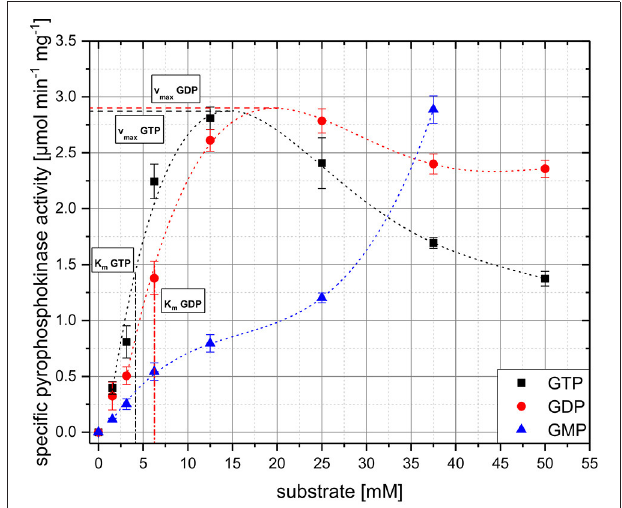
FIGURE 5 | Kinetics of RelS Cg with respect to the concentrations of GMP, GDP, and GTP as substrates. Specific activity was determined for different substrate concentrations by in vitro analysis and given in µ mol per minute per milligram of RelS Cg . In order to illustrate the data and the graphical determination of the kinetic parameters K m and v max , a polynomial fit was performed for all substrates and displayed as a dashed line. K m and v max values for GDP and GTP are represented as vertical and horizontal dashed lines, respectively. For GMP the parameters could not be determined due to the untypical activity profile. Mean values and standard deviations shown were calculated from three